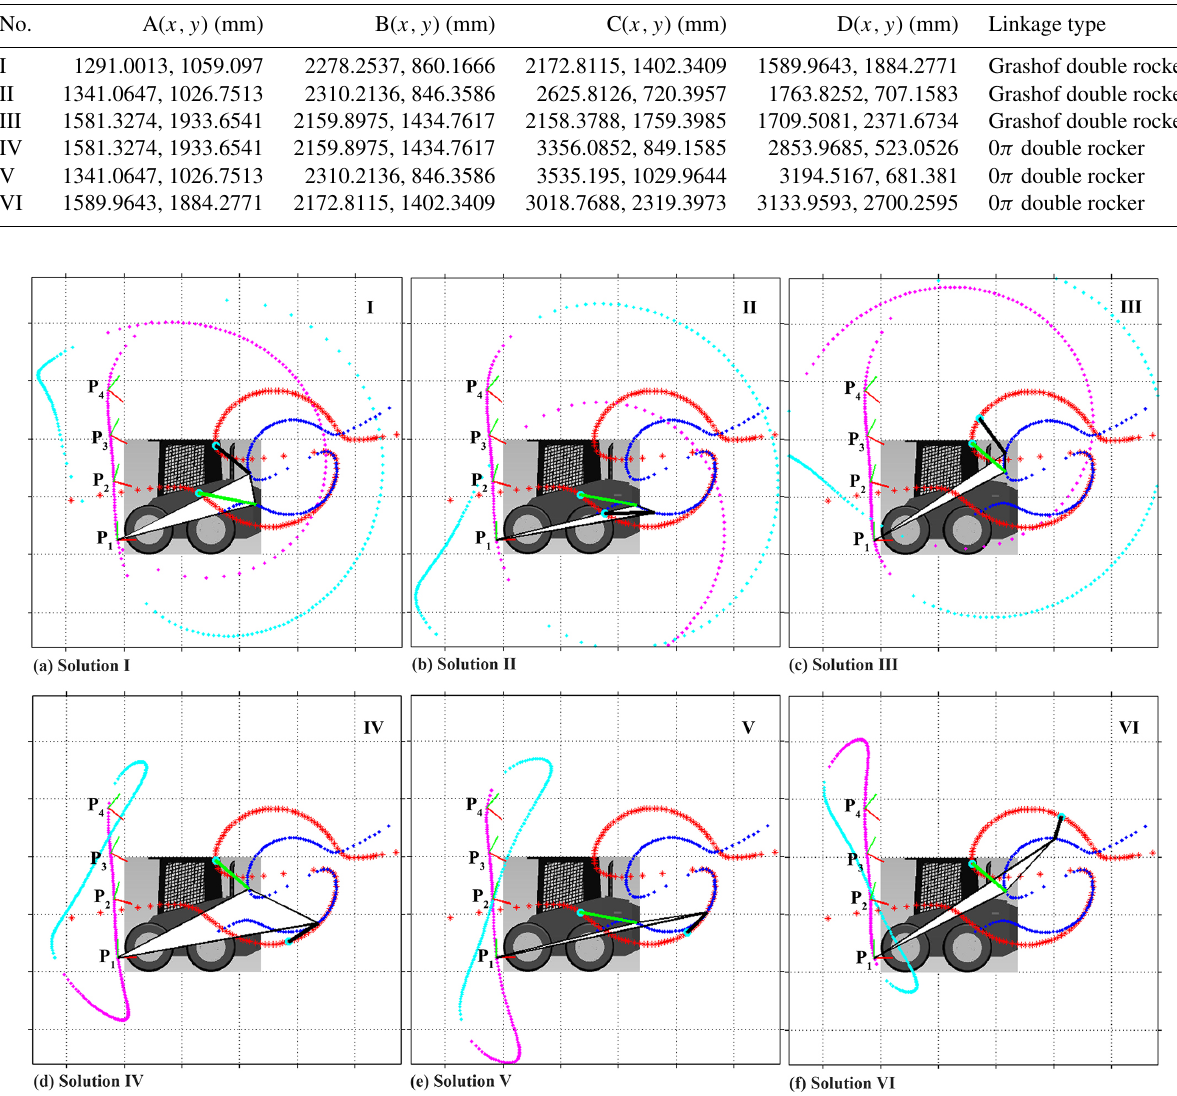
Table 5. Solutions information.